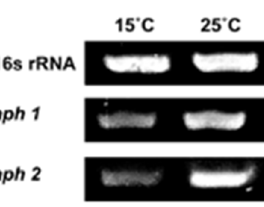
Figure 2. aph 1 and aph 2 are transcribed at 15 °C or 25 °C. The mRNA levels of aph 1 and aph 2 were quantified by semi-quantitative RT-PCR. Total RNA was extracted from Pseudomonas sp. B14-6 grown for 24 h at 15 °C and 25 °C, respectively. 16S rRNA was used as a loading control. Table 2. List of antibiotic resistance-related genes in Pseudomonas sp. B14-6.